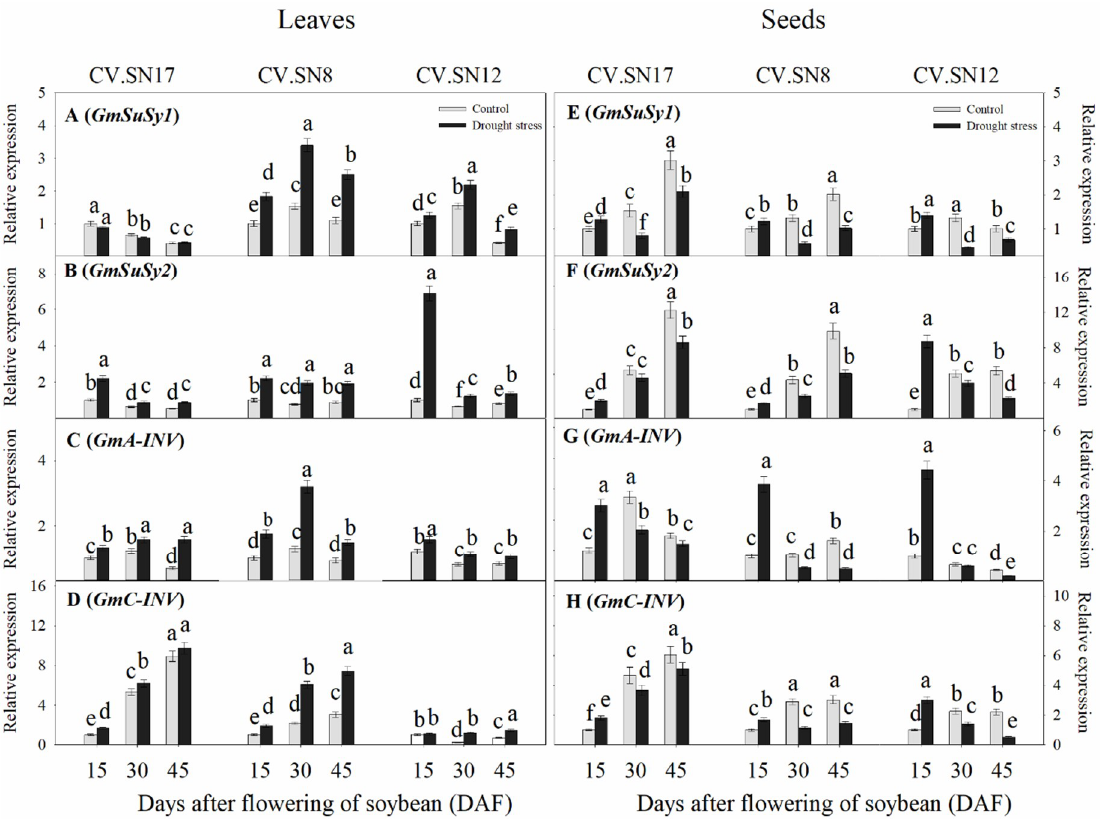
Figure 6. E ff ect of drought stress on the expression of ( A , E ) GmSuSy1 ; ( B , F ) GmSuSy2 ; ( C , G ) GmA-INV ; and ( D , H ) GmC-INV in leaves and seeds. Standard deviations were calculated with three independent experiments each comprising two soybean plants. Di ff erent letters above vertical bars indicate significant di ff erences between means at a p < 0.05 level.